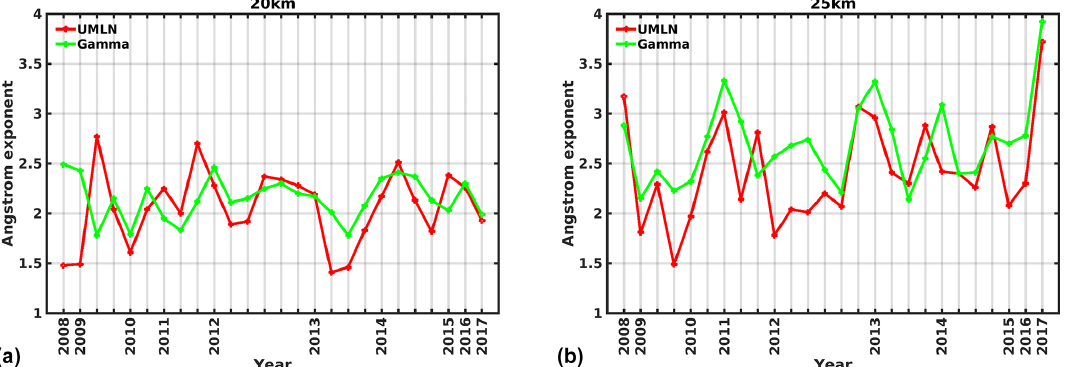
Figure 4. Computed Ångström exponents for both the UMLN (red lines) and the gamma (green lines) distribution at altitude 20km (a) and 25km (b) .